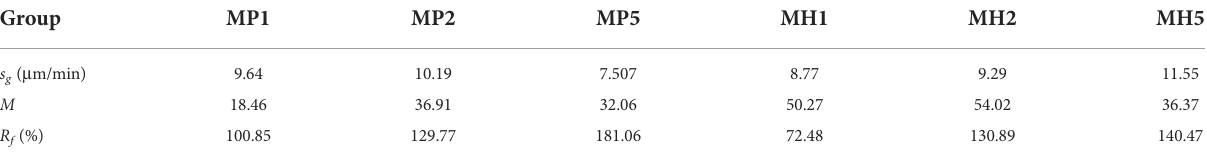
TABLE 3 Changes in parameters during self- fl occulation of modi fi ed clay under coagulation conditions. Group